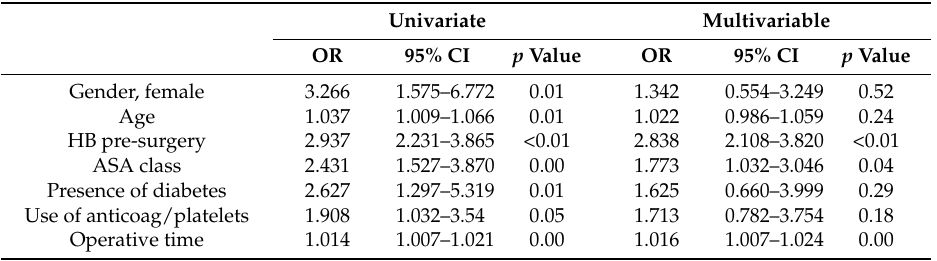
Table 3. Univariate and multivariable logistic regression models for prediction of red blood cells